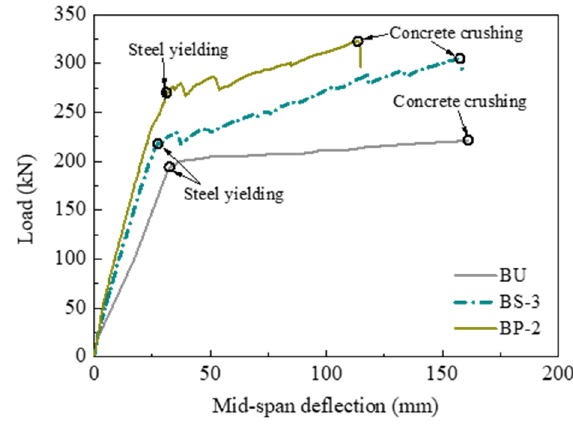
Figure 10. Influence of the prestress.